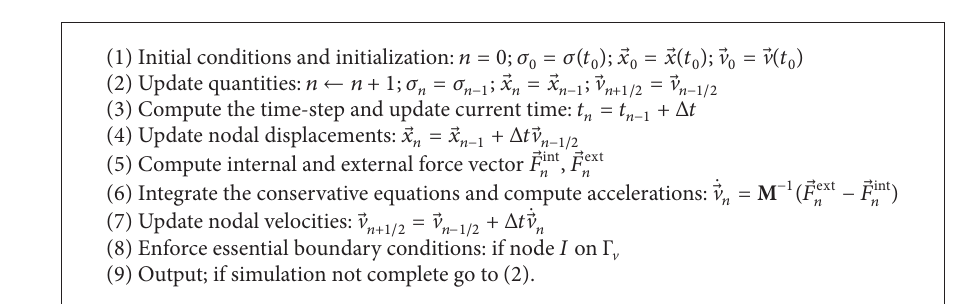
Algorithm 1: Flowchart for explicit time